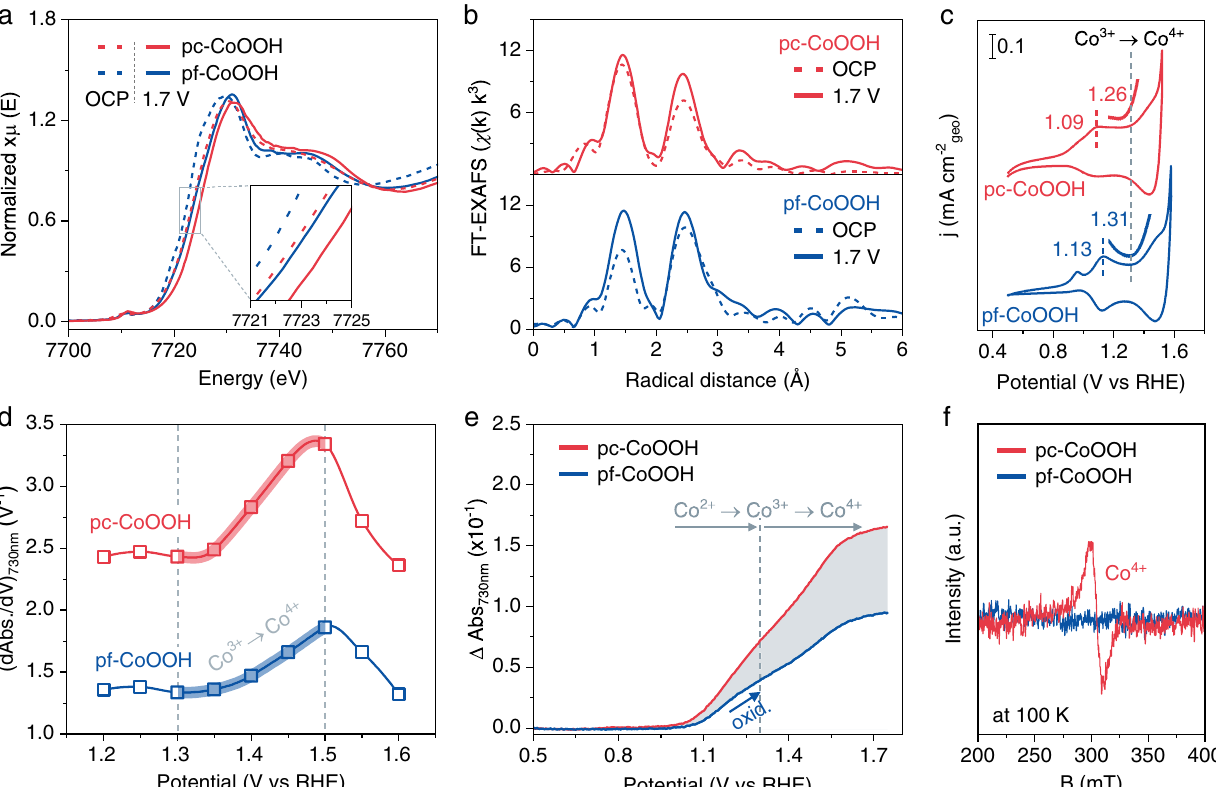
Fig. 2 | Ligand facilitated the formation of concentrated Co 4+ . a Co K-edge XANES of pf-CoOOH and pc-CoOOH atOCP and 1.7 V RHE , and b the corresponding k 3 -weightedFourier-transformedEXAFS. c Theredoxcouplesofpf-CoOOHandpc- CoOOHin1.0MNaOH,the enlarged insetsrepresent theonset oxidationpotential